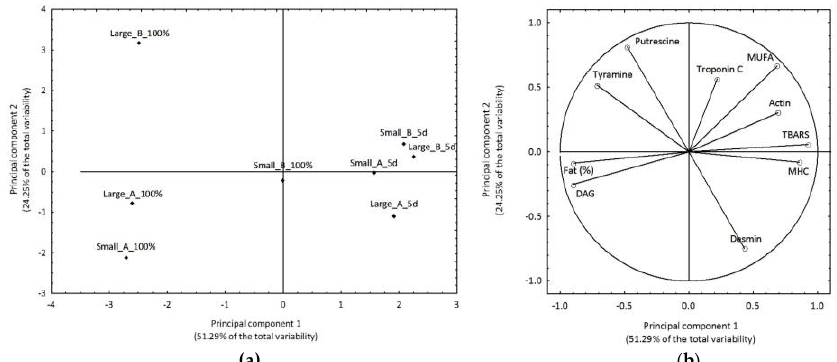
Figure 5. Case projection for the first two factors of large and small diameter sausages inoculated with starter cultures A ( Lactobacillus sakei / Staphylococcus xylosus ) or starter cultures B ( Pediococcus pentosaceus / Staphylococcus xylosus ) after fermentation and at the end of ripening ( a ) PCA loading plot of the variable selected on the first two factors obtained from PCA ( b ).